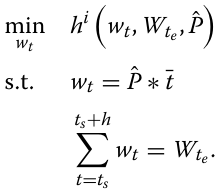
Algorithm A e minimizes CO 2 emissions (cid:2) A